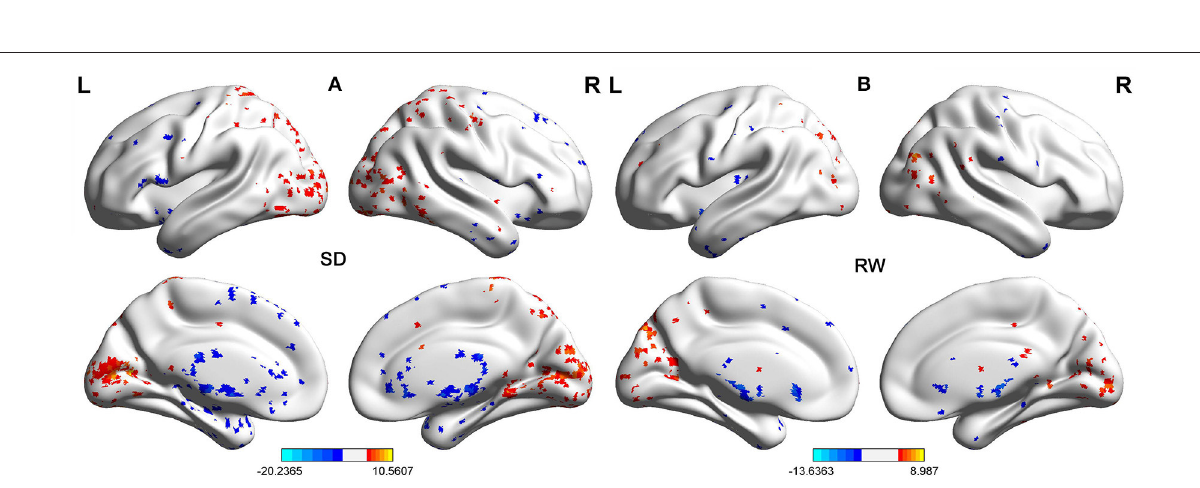
FIGURE 3 | One sample t -test differences of SD and RW in Binarized longFCD. The Binarized longFCD maps in the SD group (A) and the RW group (B) , respectively. These maps are the results of the within-groups using one-sample t -tests, corrected by FDR. L, left; R, right; SD, sleep deprivation; RW, rested wakefulness; longFCD, long-range functional connectivity density; FDR, false discovery